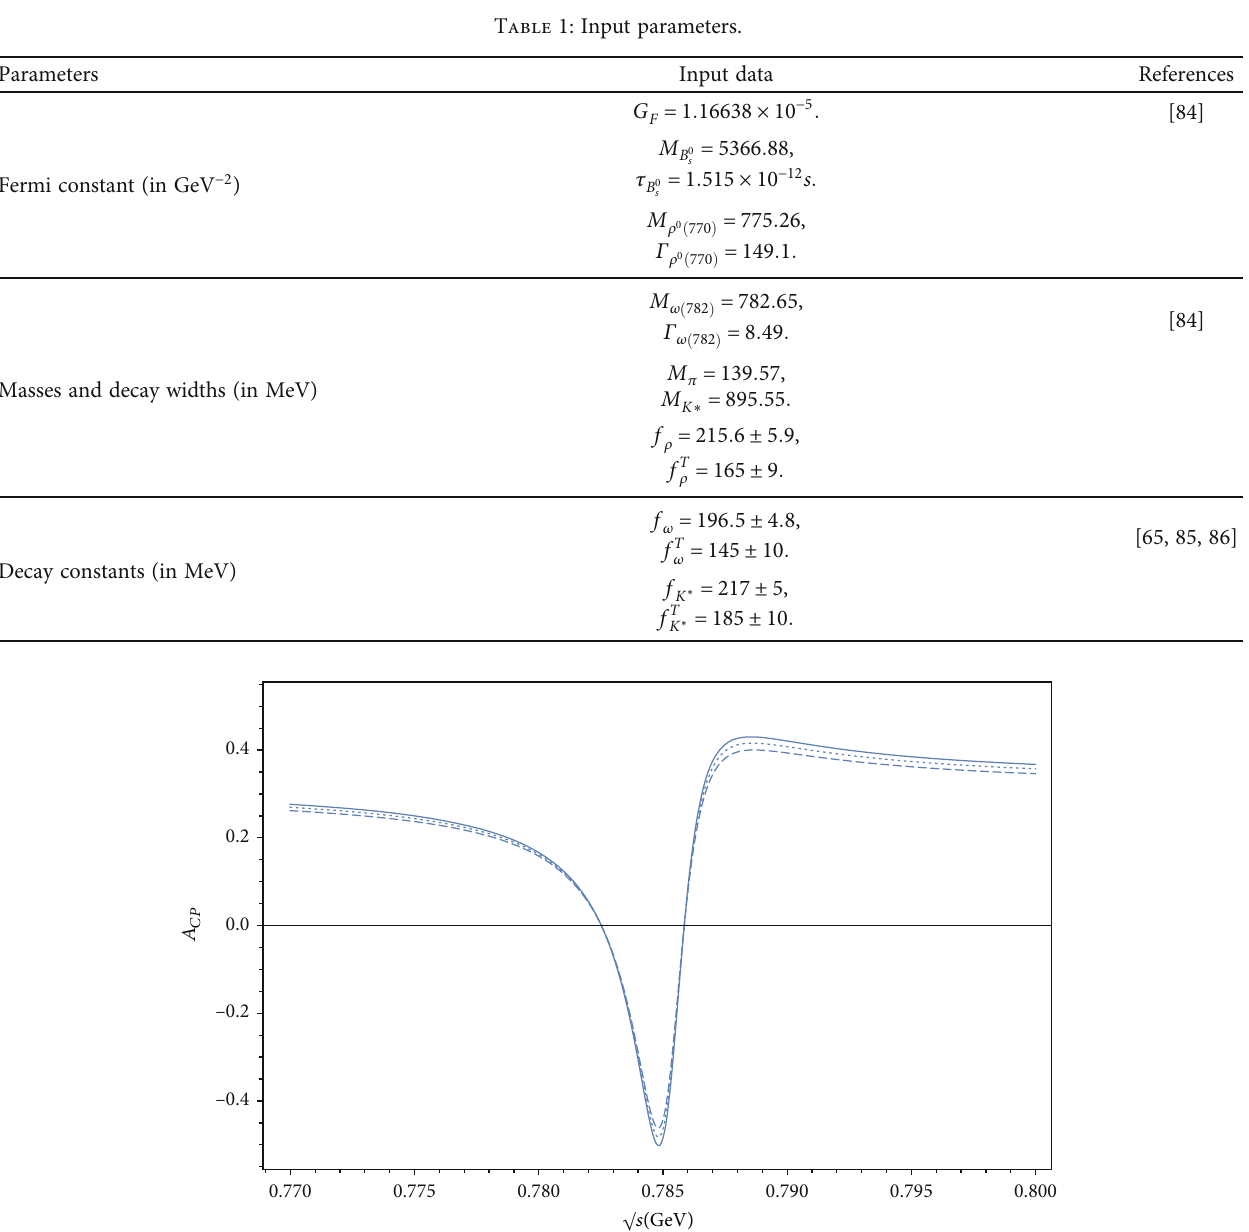
ffiffi p for di ff erent CKM matrix elements. The solid line, dotted line, and dashed line s